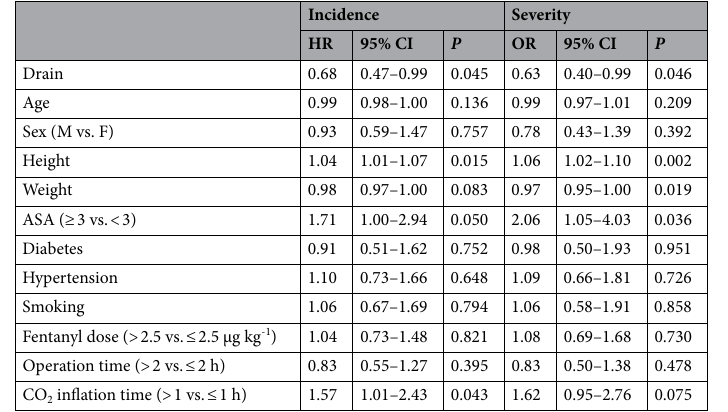
Table 3. Multivariable analysis of miscellaneous factors on the incidence and the more pain severity of PLSP. HR hazard ratio, OR Odds